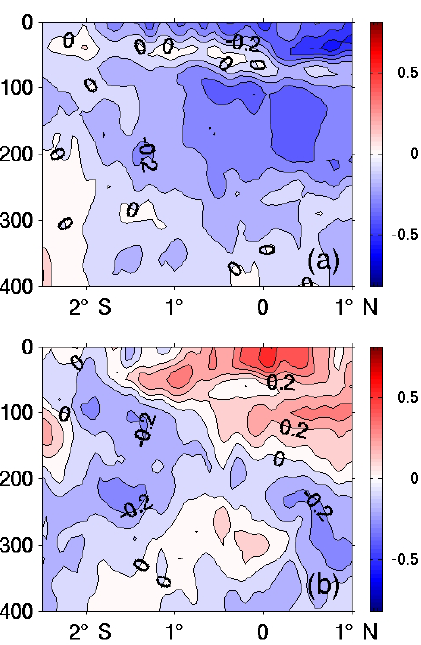
Figure 7. ADCP zonal (positive eastward) (a) and meridional (posi- tive northward) (b) velocity sections (inms − 1 ) on the diagonal sec- tion from the Ecuadorian shelf at ∼ 2 ◦ 30 (cid:48) S to 1 ◦ N, 85 ◦ 30 (cid:48) W on 5 and 6 October 2015 (see Fig. 1). The contour interval is 0.1ms − 1 .